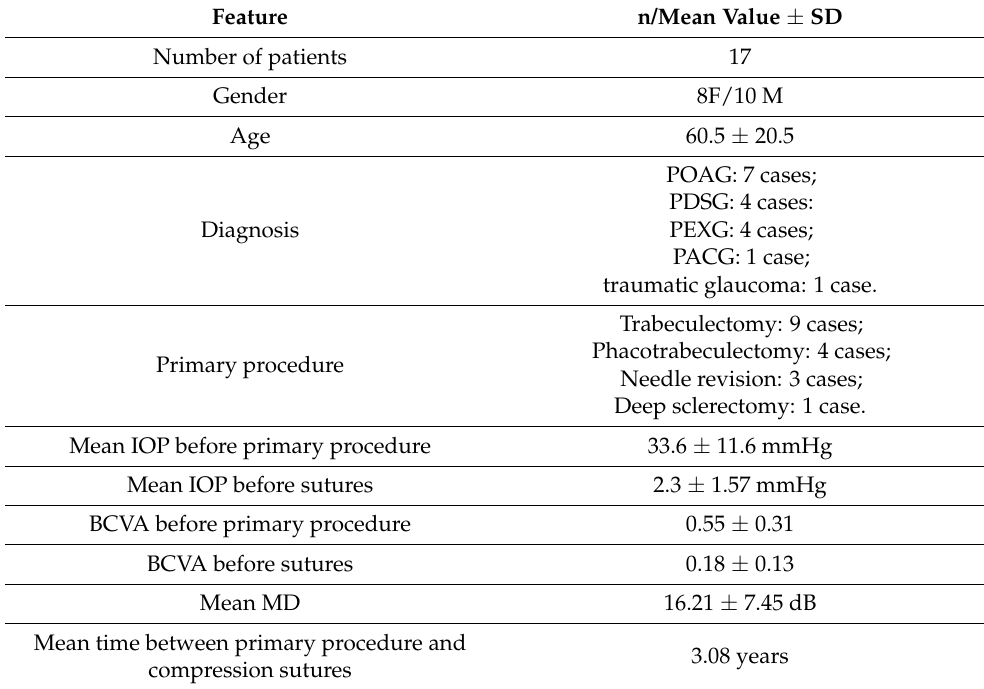
Table 1. Clinical and demographic characteristics of the studied group.